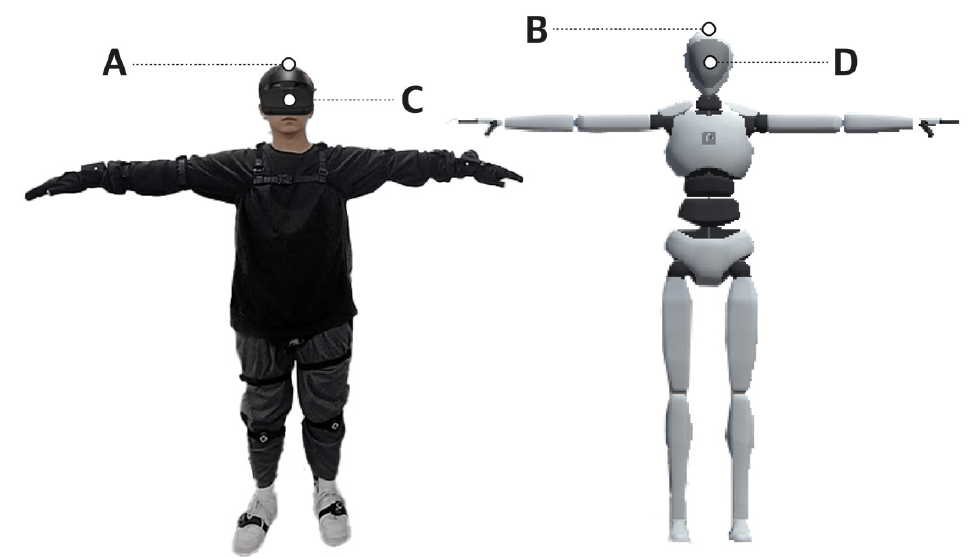
Figure 8. How to synchronize character scale according to user body information.